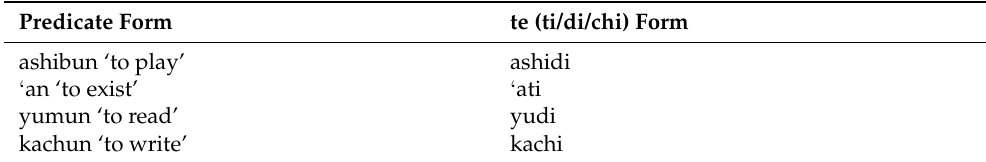
Table 11. Uchinaaguchi Predicate form and -te form.